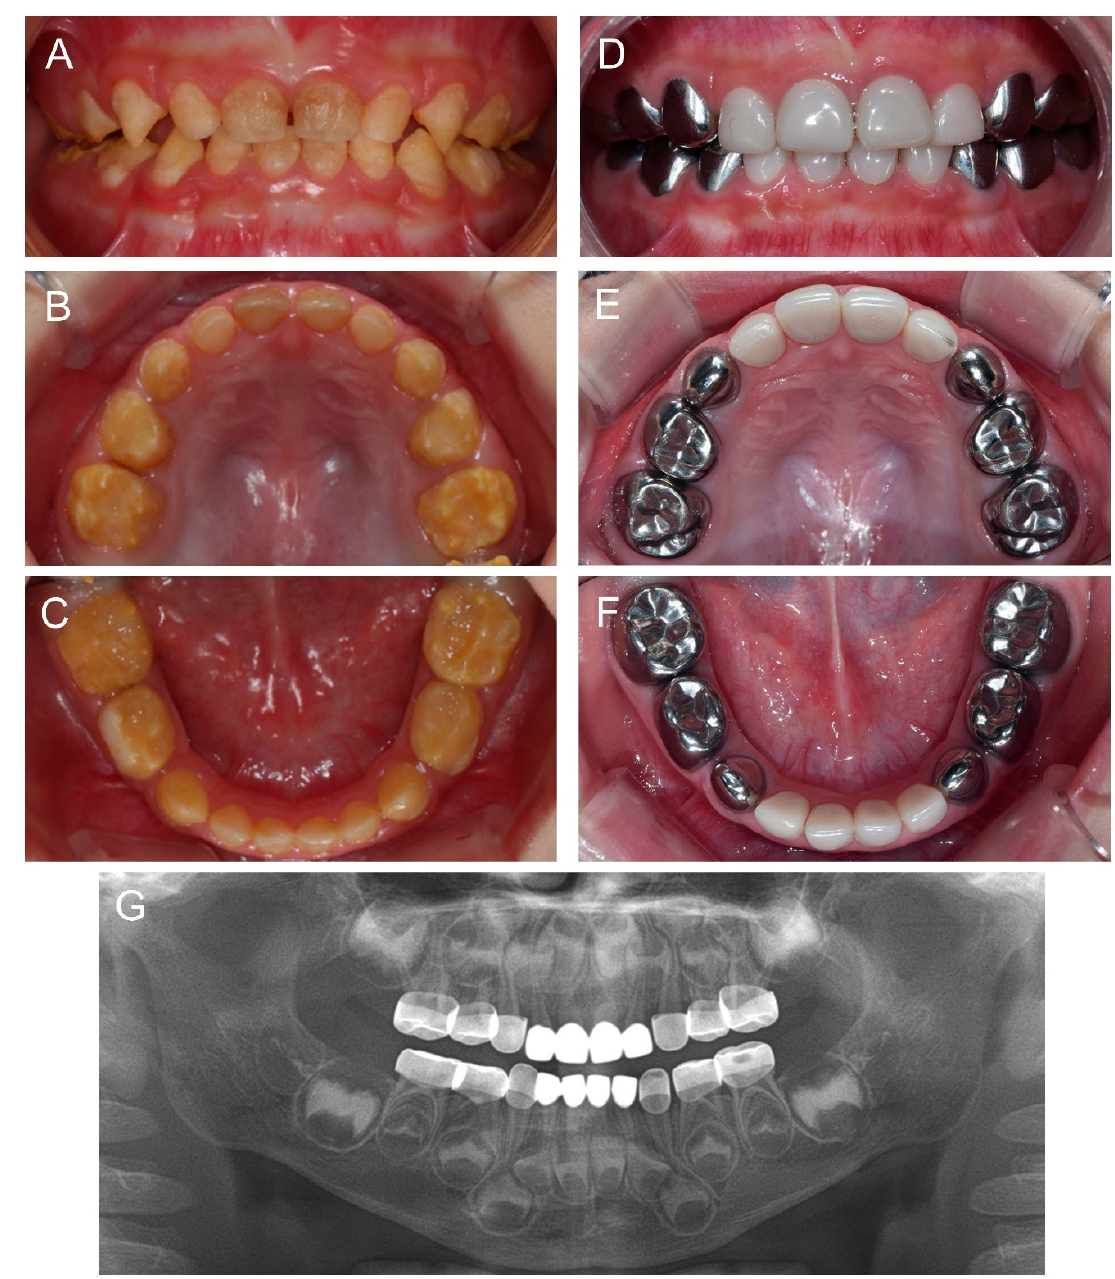
Figure 5. Clinical photos and panoramic radiograph of the affected individual (IV:2). ( A – C ) Clinical photos of the proband before the treatment at age 2 years 9 months. ( D – F ) Clinical photos of the proband after the treatment at age 3 years 6 months. The deciduous molars and canines were treated with stainless steel crowns and all anterior teeth were treated with zirconia crowns. ( G ) Panoramic radiograph at age 3 years 6